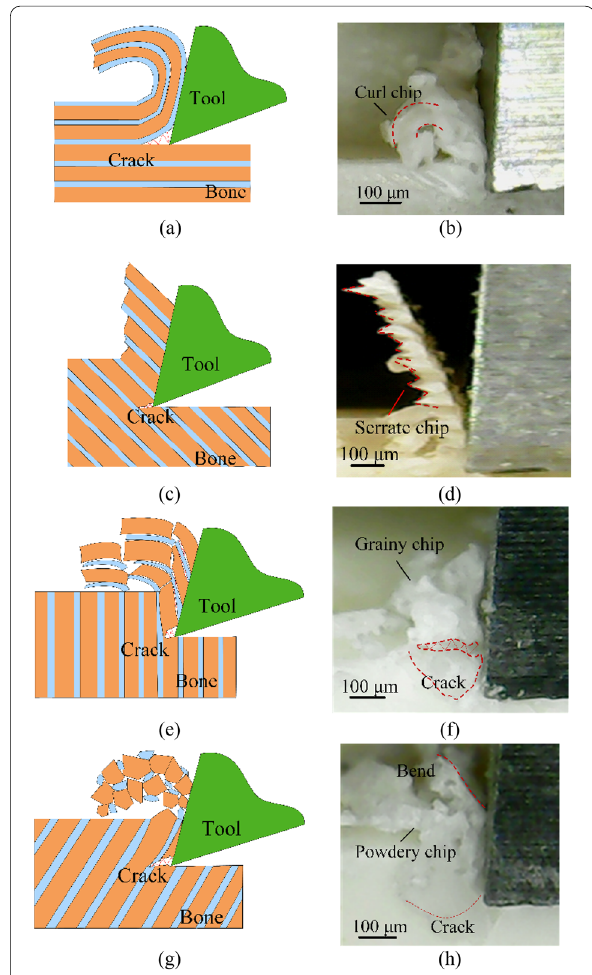
Figure 14 Chip formations in depth of cut 130 μm: a Cutting model for mode #1, b Curl chip in mode #1, c Cutting model for mode #2, d Serrated chip in mode #2, e Cutting model for mode #3, f Grainy chip in mode #3, g Cutting model for mode #4, and h Powdery chip